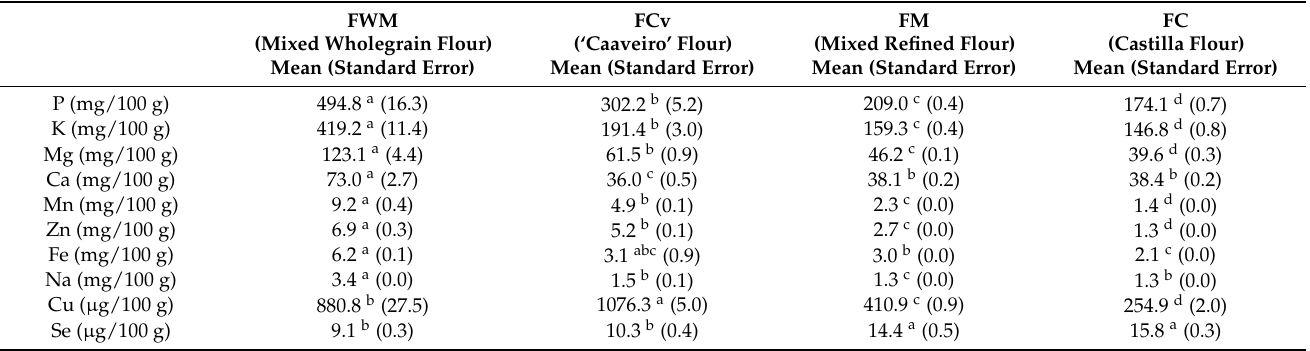
Table 2. Element content (trimmed mean and standard error) of ten replicates for elements in the wheat flours on a dry weight basis (d.w.). Moisture means were: 10.9% (FWM), 10.0% (FCv), 9.6% (FM) and 10.3% (FC).